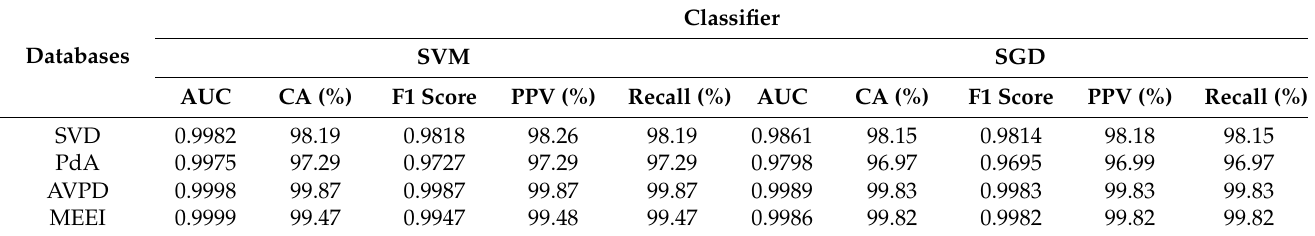
Table 7. Performance parameters of classifiers SVM and SGD for three most common descriptors.